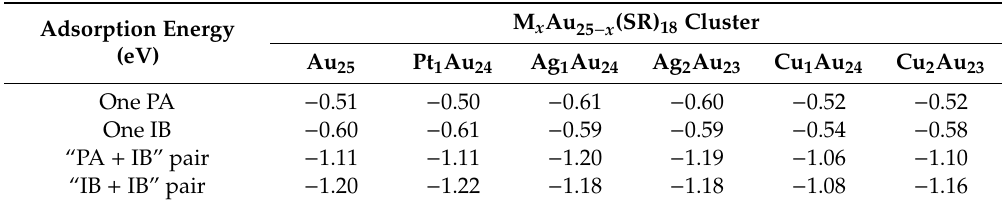
Table 6. Adsorption energy of the PA and IB on the Au 3 site of the M 1 Au 24 (SR) 18 (M: Pt, Ag, and Cu, and noted as M 1 Au 24 ) and M 2 Au 23 (SR) 18 (M: Ag and Cu, M 2 Au 23 ) cluster models, respectively.